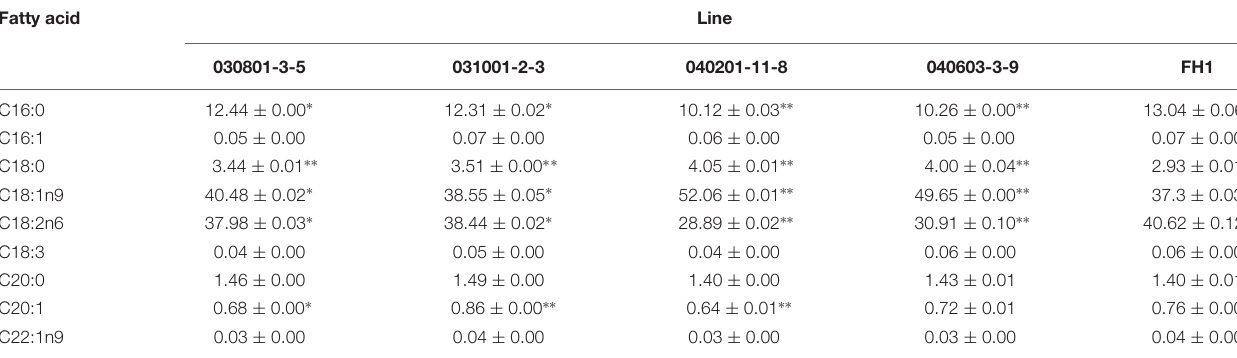
TABLE 3 | Comparison of FA composition and relative FA contents in mature seeds between FH1 and transgenic peanut lines (%). Fatty acid